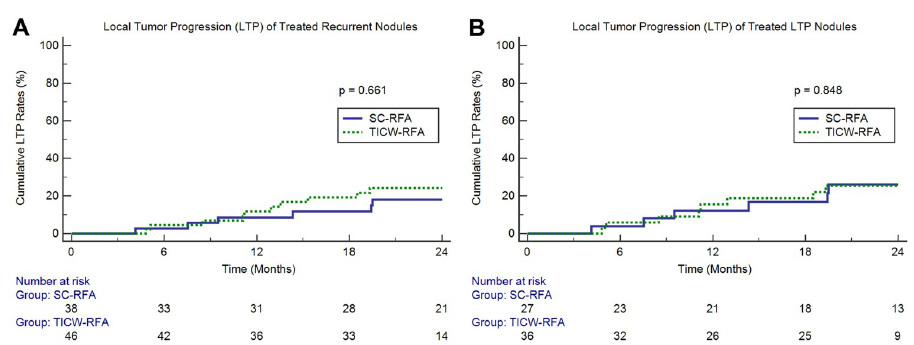
Fig 3. Cumulative LTP rates after RFA of (A) overall recurrent nodules and (B) nodules that presented as LTP.